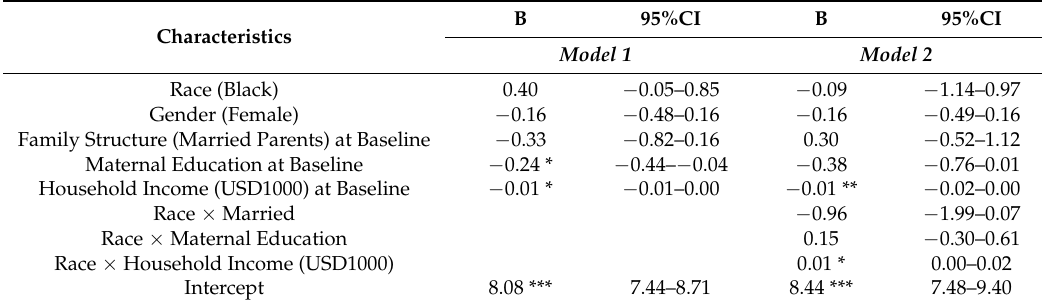
Table 3. Summary of linear regression models in the overall sample ( n =